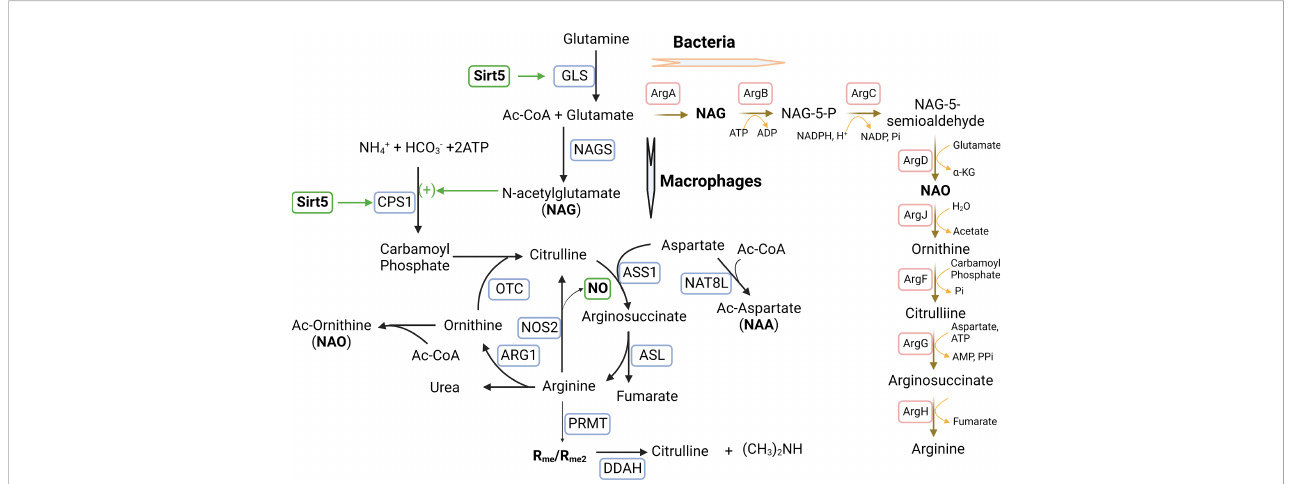
FIGURE 4 Sirtuin5 plays a vital role in arginine metabolism during macrophage activation and polarization. Arginine is converted into citrulline to release NO in M1- M F s where iNOS/NOS2 is up-regulated, whereas arginine is converted into ornithine in M2-M F s where ARG1 is up-regulated. In addition, arginine metabolism is regulated by glutamine metabolism which is involved in the urea cycle by N-acetylglutamate (NAG). NAG which is an allosteric activator and is required for the initial and rate-limiting enzyme of the urea cycle, carbamoyl phosphate synthetase 1 (CPS1). The formation of this unique co- substrate from glutamate and acetyl Coenzyme-A is catalyzed by NAG synthase (NAGS). Sirtuin-5 (SIRT5) desuccinates and activates CPS1 to promote the formation of carbamoyl phosphate from ammonia. Carbamoyl phosphate can modify ornithine to form citrulline through the enzyme ornithine transcarbomoylase (OTC). Citrulline can react with aspartate facilitated by the catalytic enzyme arginosuccinate synthetase (ASS1) to form arginosuccinate, which can return to arginine and fumarate through argininosuccinate lyase (ASL). Both aspartate and ornithine can be acetylated to form acetylated aspartate (NAA) and acetylated ornithine (NAO). Asymmetric di-methylated arginine (ADMA/R me2 ) can be hydrolyzed by enzyme dimethylarginine dimethylaminohydrolase (DDAH) into citrulline and dimethylamine. In bacteria, arginine biosynthesis can start with glutamate acetylation and a set of bacterium-speci fi c catalytic enzymes (ArgA-H) are involved. Additional Symbols : NAT8L, N-acetyltransferase 8 like; PRMT, Protein arginine